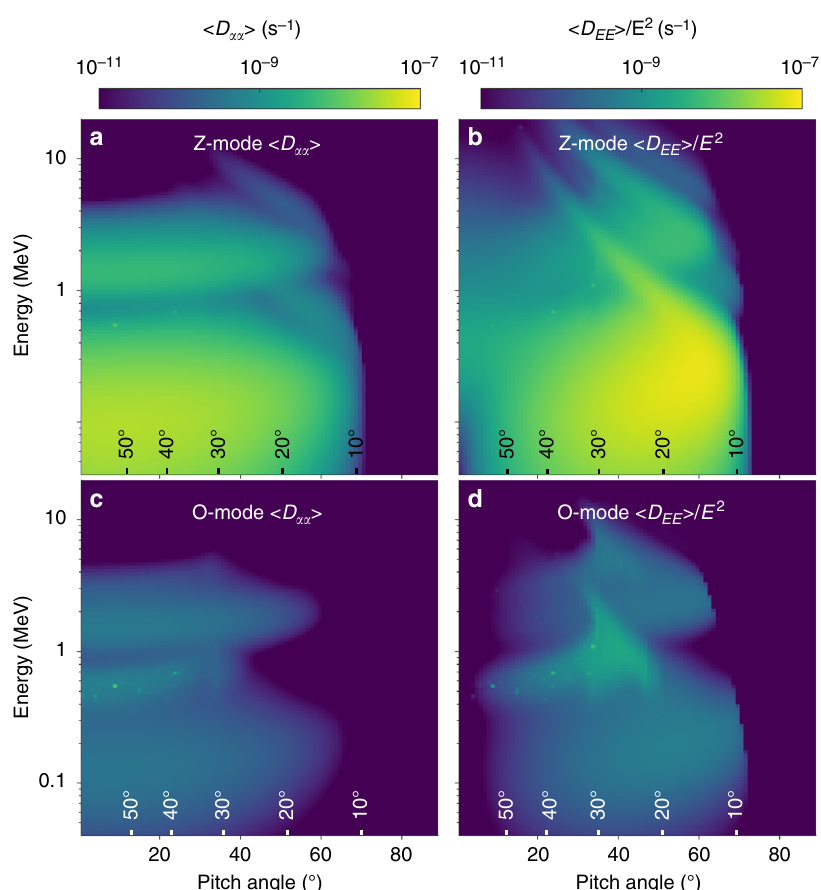
Fig. 3 Bounce and drift averaged electron diffusion coef fi cients. a Pitch angle diffusion from Z-mode waves, 〈 D αα 〉 . b Energy diffusion from Z-mode waves, 〈 D 〉 / E 2 . c same as a but for O-mode waves. d Same as b but for O-Mode waves. The color scale indicates the strength of the diffusion. The labels above EE the horizontal axes show the maximum latitude (mirror latitude) an electron with the corresponding pitch angle would reach during its bounce